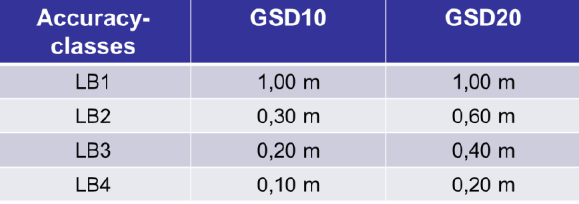
Figure 4: Productclassification, defined by orientation